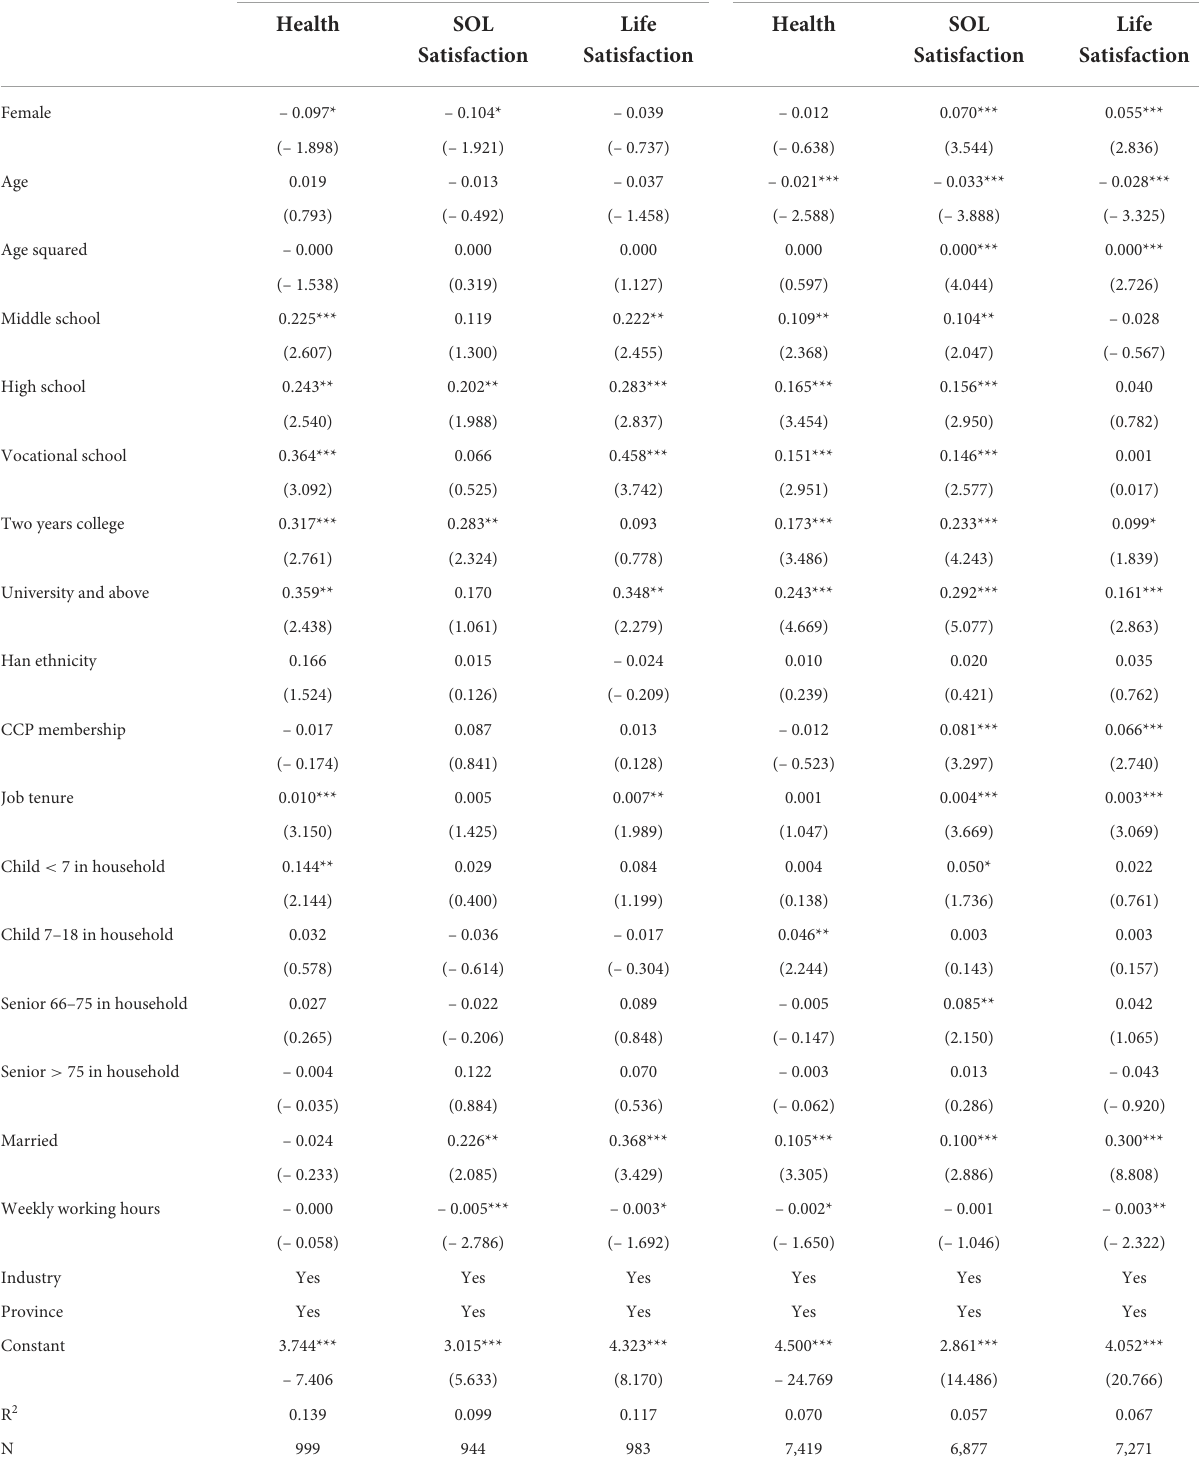
TABLE 2 Well-being regressions for self-employed and